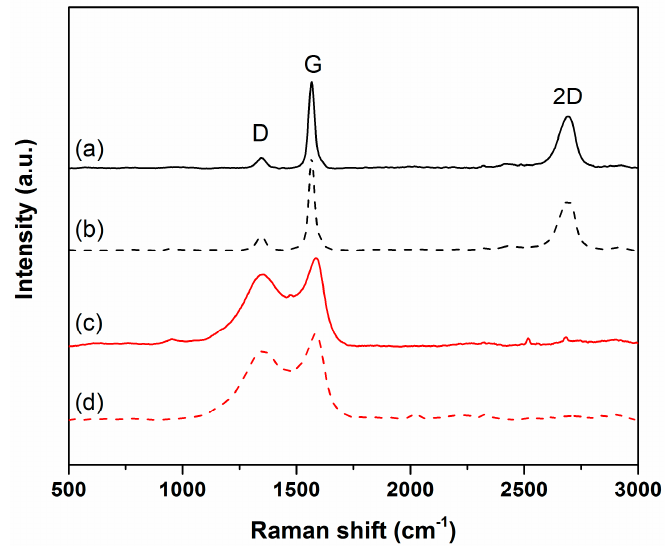
Figure 5. Raman average spectra of the fillers and films: (a) graphene filler (solid black line); (b) graphene film (dash black line); (c) biochar filler (solid red line); (d) biochar film (dash red line).